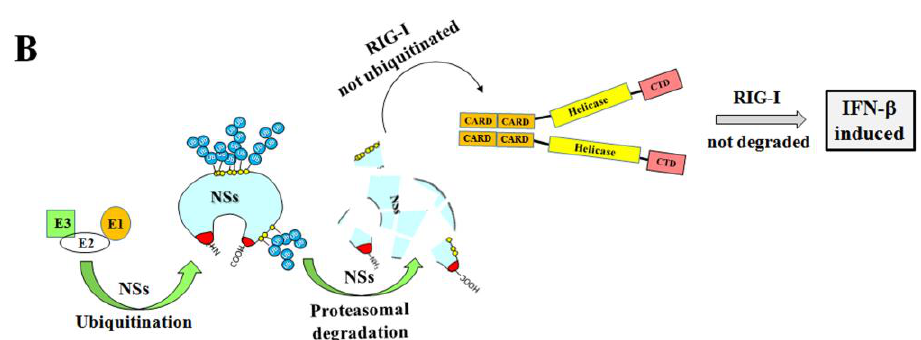
Figure 8. Cartoon representation of the putative function of the TOSV NSs on RIG-I-mediated interferon beta production and the influence of ubiquitination on the viral protein function. ( A ) The TOSV NSs protein accumulated in the cell cytoplasm efficiently interacts with RIG-I and mediates its ubiquitination and subsequent degradation, counteracting IFN- β production. On the contrary ( B ), the high ubiquitination rate of the NSs negatively affects its stability, targeting the protein for proteasomal degradation. Consequently, RIG-I is not depleted and the physiological secretion of IFN- β occurs.